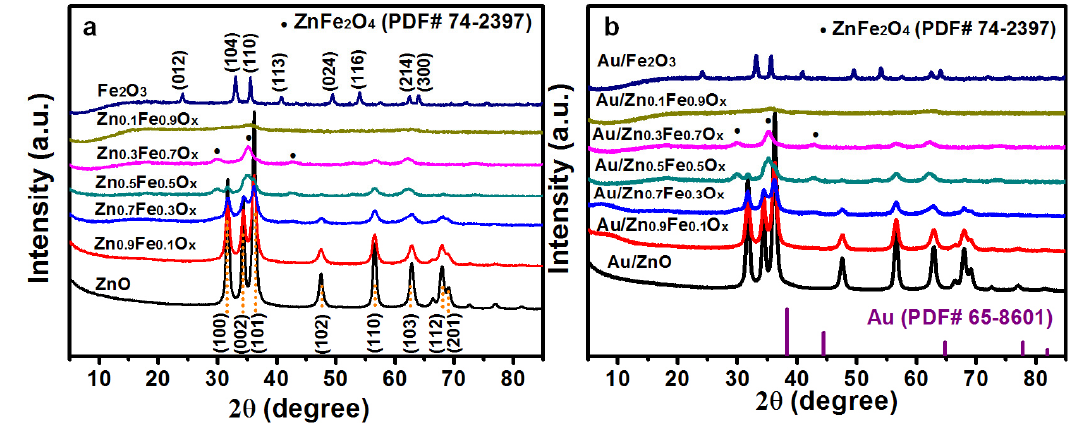
Figure 1. XRD pattern of ( a ) supports and ( b ) supported gold nanocatalysts.